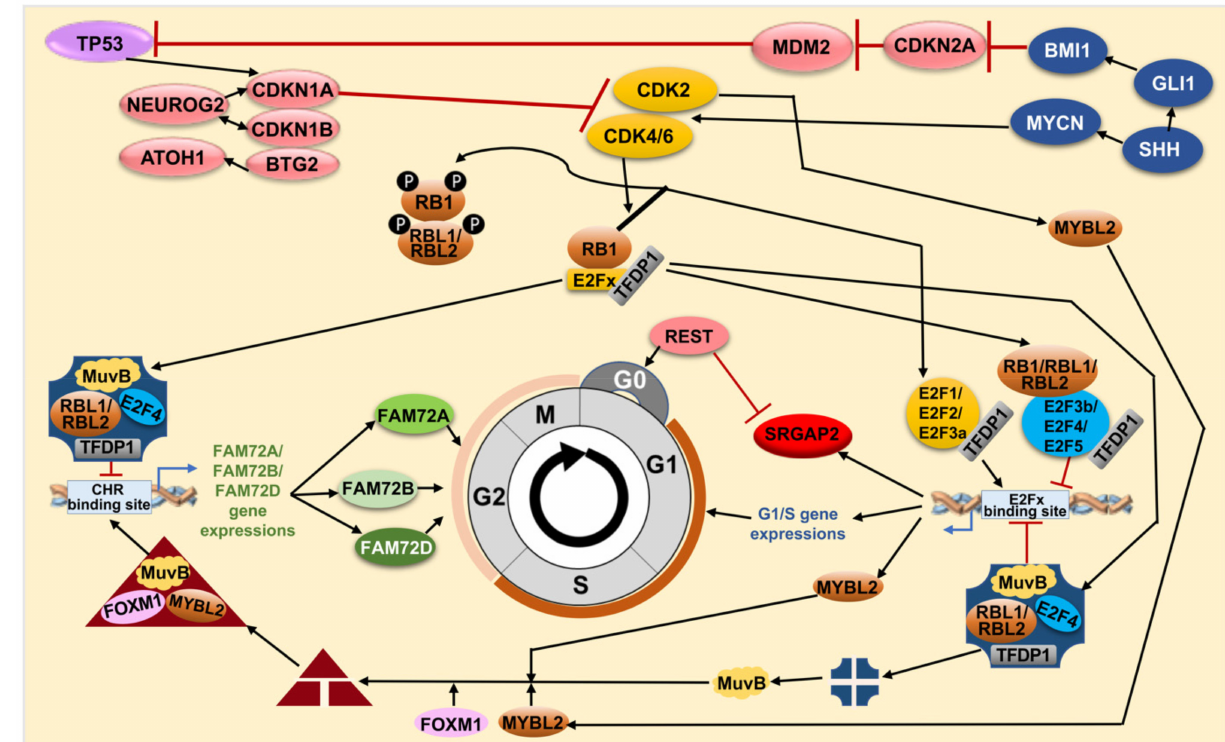
Figure 6. FAM72 paralog-specific cell cycle signaling mediated by various TFs. DREAM (blue rectangle) is composed of TFDP1, RBL1 or RBL2, the E2Fx TFs E2F4, or E2F5 and the MuvB core complex (consists of LIN9, LIN37, LIN52, RBBP4 (LIN53), LIN54). During quiescence/G0 and early G1 phases of the cell cycle, DREAM represses cell cycle gene expression. When these G0/G1 stages end, DREAM gets inactivated so that the MuvB complex dissociates away to form a new complex with the MYBL2 and FOXM1 called the MMB-FOXM1 complex (red triangle, MuvB, MYBL2 and FOXM1). This new complex promotes late cell cycle gene expression and is required to pass through the G2/M phases [80]. At the end of the M-phase, REST inhibits neuronal gene expression (such as SRGAP2) to allow re-entry into a new cycle, thus maintaining NSC renewal and FAM72 expression. Once it receives a neurogenic signal, REST is degraded, FAM72 expression is blocked, and SGRAP2 expression is initiated for neuronal differentiation. ATOH1, Atonal basic helix-loop-helix (bHLH) TF 1; BMI1, B cell-specific Moloney murine leukemia virus integration site 1; BTG2, B-cell translocation gene 2;CDK2/4/6, Cyclin dependent kinase 2/4/6; CDKN1A/1B/2A, Cyclin dependent kinase inhibitor 1A/1B/2A; FOXM1, Forkhead box M1; GLI1, Glioma-associated oncogene family zinc finger 1; MDM2, Murine double minute 2; MuvB, Multi-vulval class B complex; MYBL2, v-myb avian myeloblastosis viral oncogene homolog-like 2; MYCN, v-myc avian myelocytomatosis viral oncogene neuroblastoma derived; NEUROG2, Neurogenin 2; REST, Transcriptional repressor RE1 silencing transcription factor; SHH, Sonic hedgehog signaling